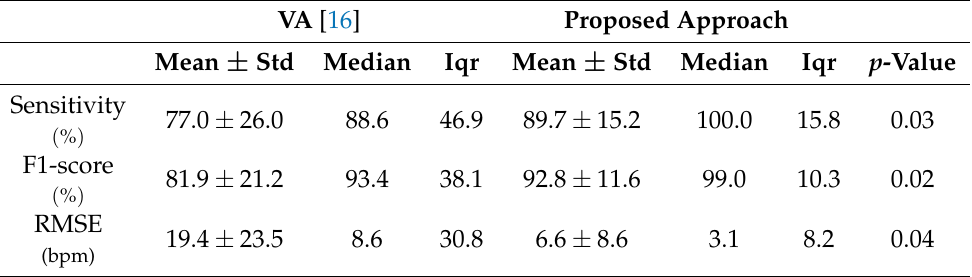
Table 3. Mean ± standard deviation, median value, interquartile range (iqr) of the proposed metrics evaluated on DS-SS (Semi-Simulated Database) with VA and the proposed methods. To compare the methods, the p -value is reported. DS-SS dataset contains 27 semi-simulated subjects.